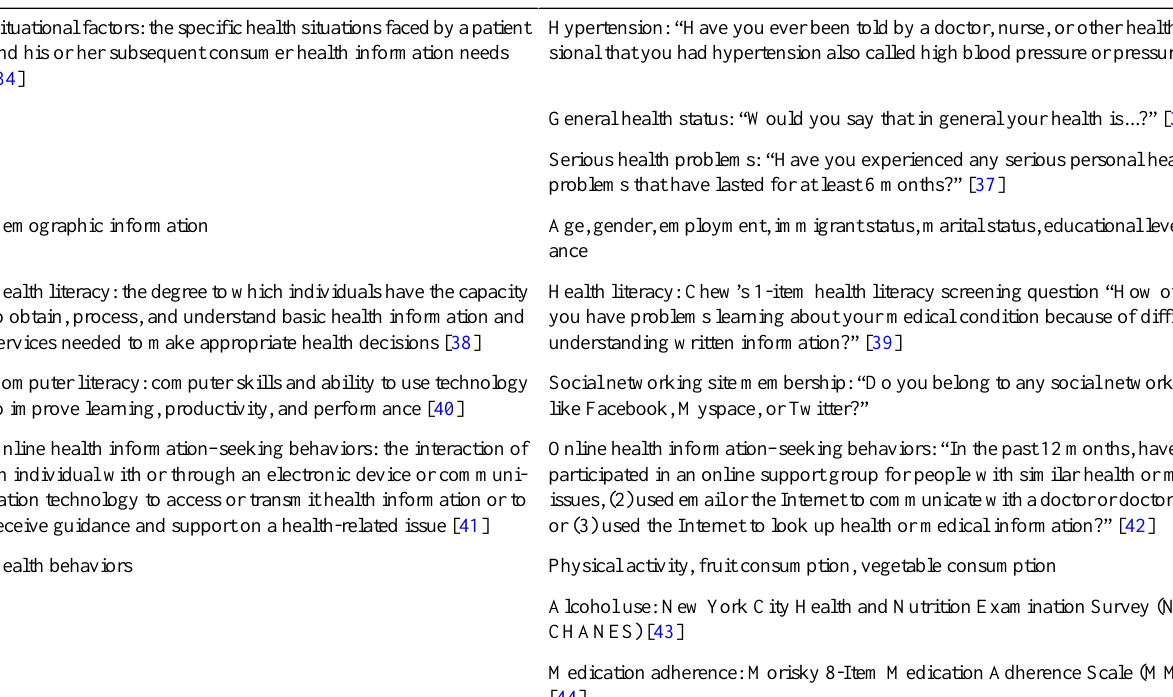
Table 1. Conceptualization and measurement of study